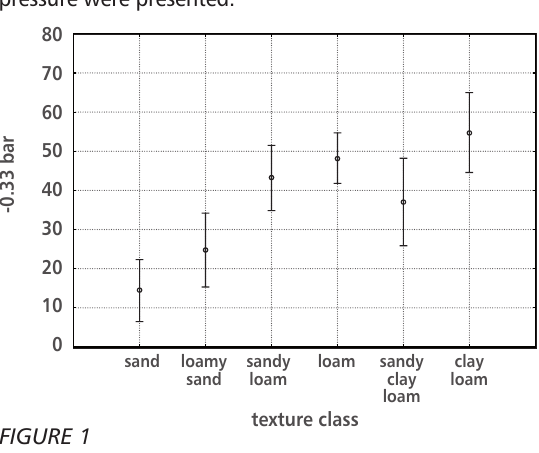
Water-retention effects at the pressure of -0.33 b (vol.%) compared to the texture class The retention of water at the pressure of 0.33 bar was the least in the sand (13.9 vol.%) and soils of a light- mechanical composition, and gradually increased to clay loam textural classes (55.4 vol.%), except in the texture class of sandy clay loam, where the retention of water was slightly lower. The most significant differences are between the sand and loamy sand compared to clay loam (p = 0.00000). It may be noticed that the increase in the proportion of the clay fraction, also meant the increase in the value of water retention at -0.33 bar. Thus, Živanov [1,16] stated the following values of water retention at -0.33 bar for alluvial soil textural classes taken from the alluvial plains of the Danube, Drava and Tamiš: sand 7.1 vol.%, loamy sand 20.3 vol.%, sandy loam 32.2 vol.% loam 48.5 vol.%, powdered clay 51.7 vol.%. Studying the Middle Danube lands, the water retention values at -0.33 bar were in scope of the following interval: from 3.4 to